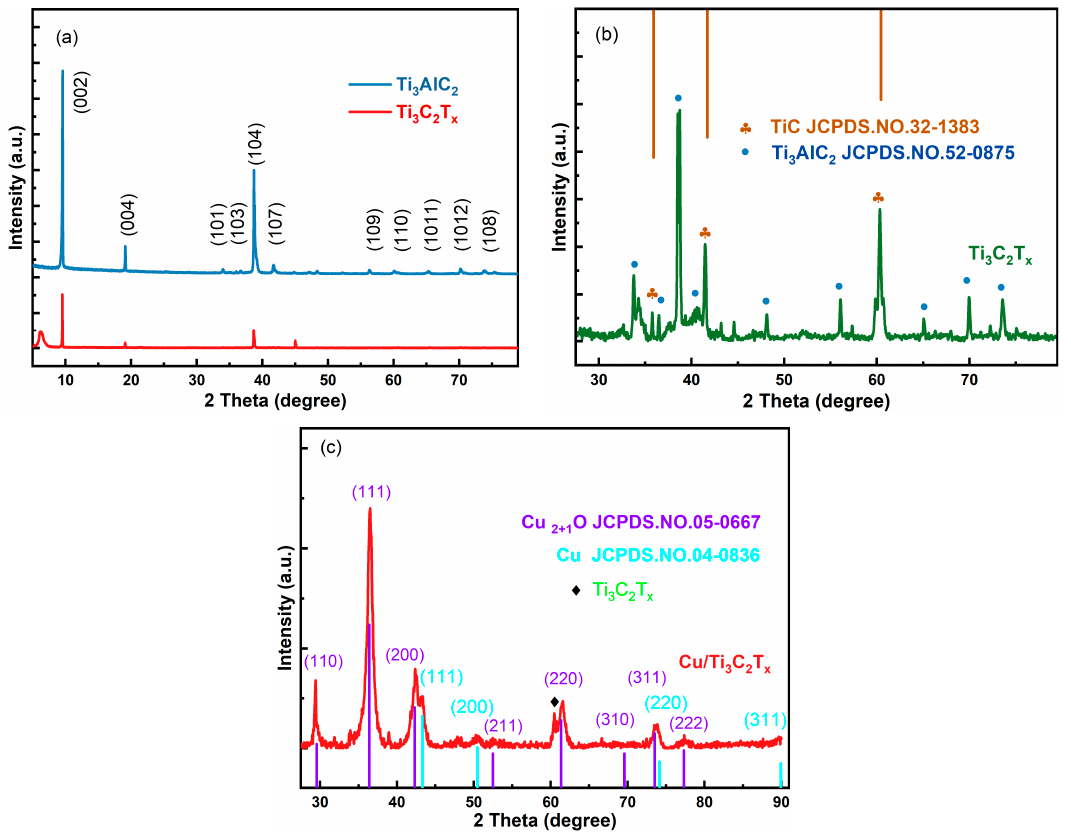
Figure 5. XRD pattern of ( a ) Ti 3 AlC 2 and Ti 3 C 2 T x ; XRD pattern of ( b ) Ti 3 C 2 T x and ( c ) Cu/Ti 3 C 2 T x .